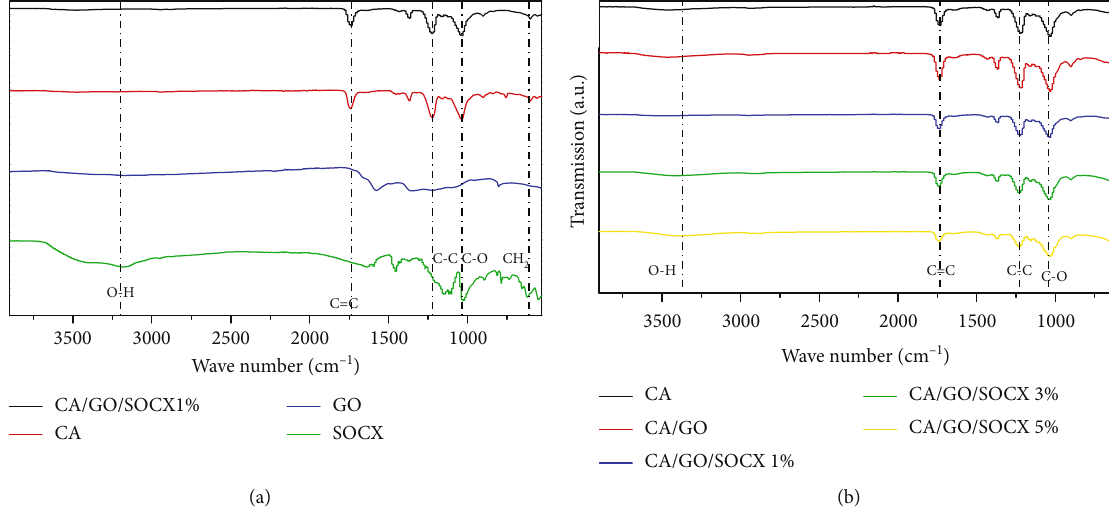
Figure 3: (a) FTIR spectra of starting material CA, GO, SOCX, and combined CA functionalized GO with 1% p-SOCX, (b) FTIR spectra of nano fi bers of CA, GO functionalized CA, and GO functionalized CA with di ff erent amount of p-SOCX (1%, 3% and